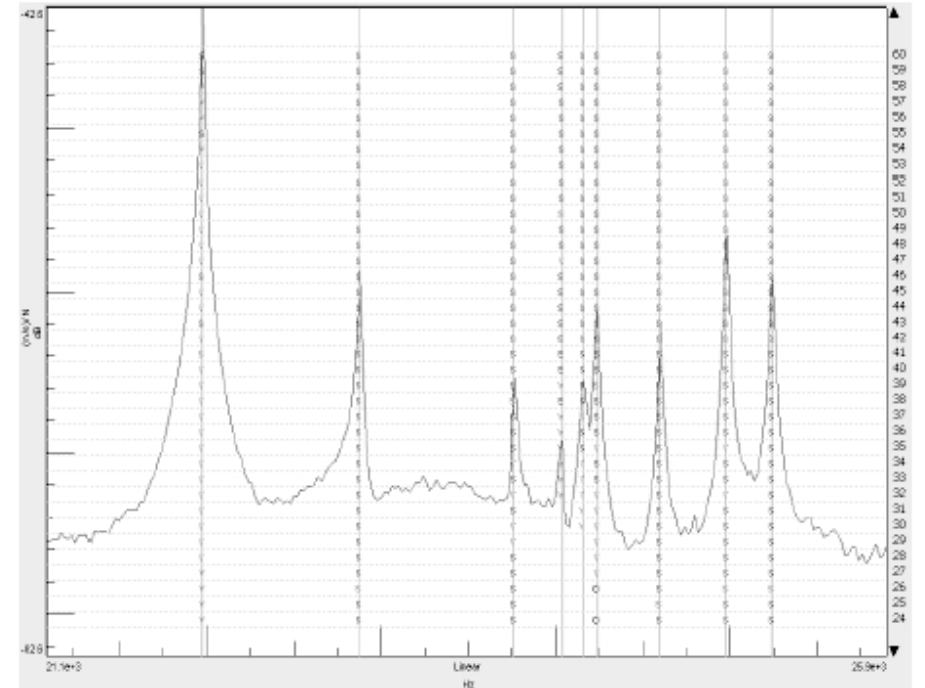
Fig. 11. The stabilization diagram Microflown based test.